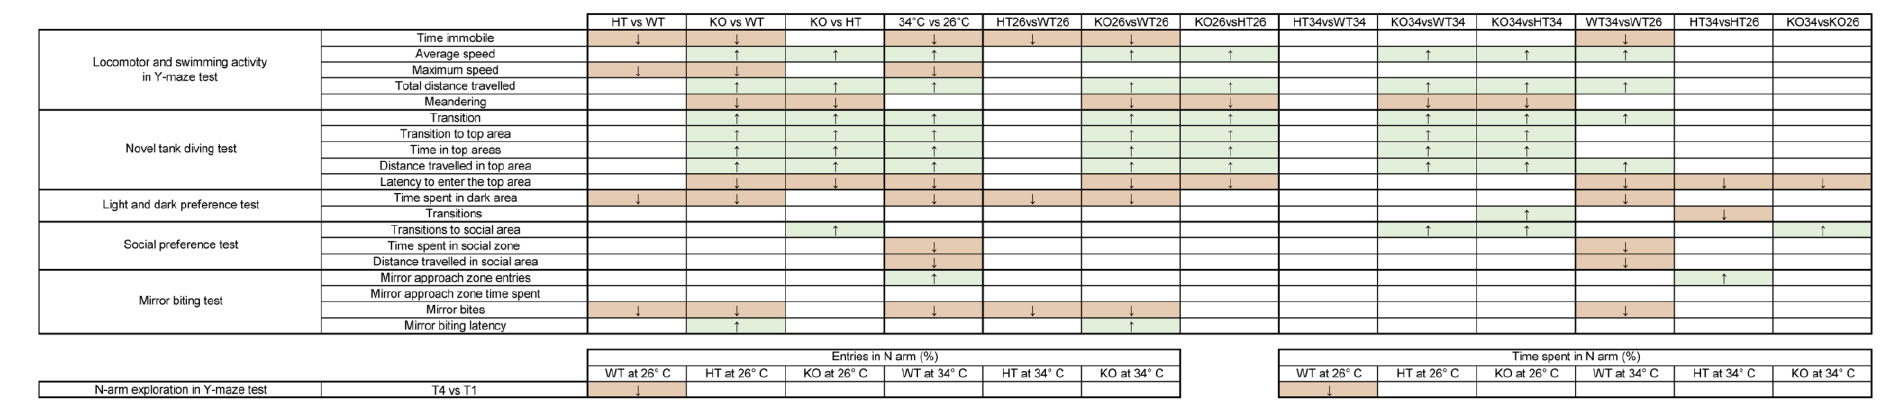
Figure 14. Schematic summary of behavioural analysis reported in Tables S21 – S26 and in Figures 8 – 12. HT26 vs. WT26, KO26 vs. WT26, KO26 vs. HT26, HT34 vs. WT34, KO34 vs. WT34, KO34 vs. HT34, WT34 vs. WT26, HT34 vs. HT26 and KO34 vs. KO26 are considered. Reduction ↓ , increase ↑.